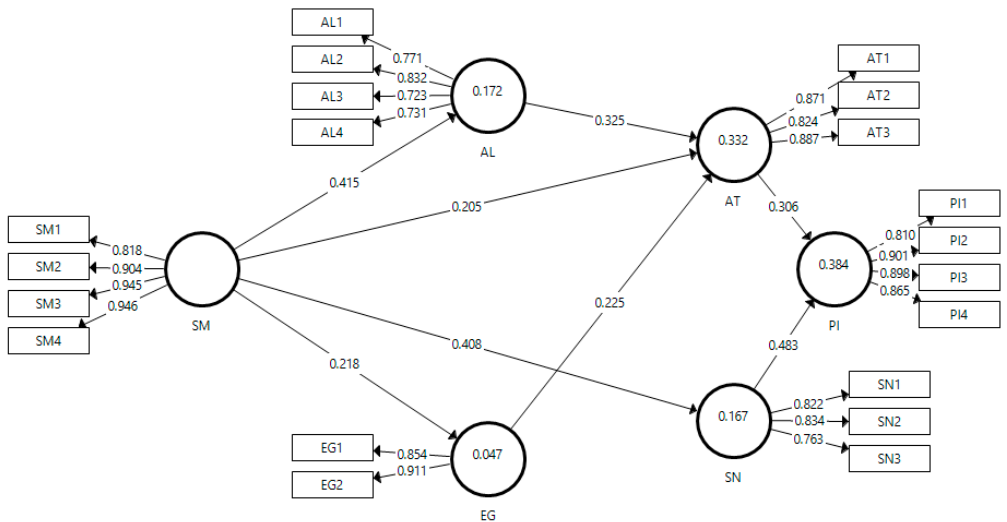
Figure 2. The structural model.